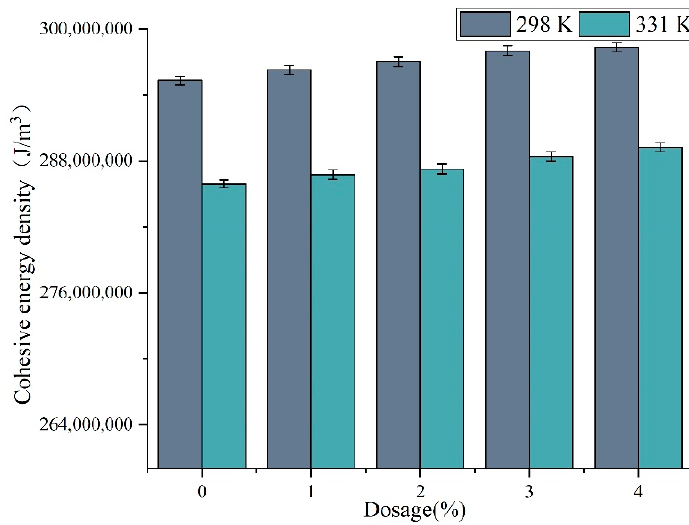
Figure 14. The cohesive energy density of the model.